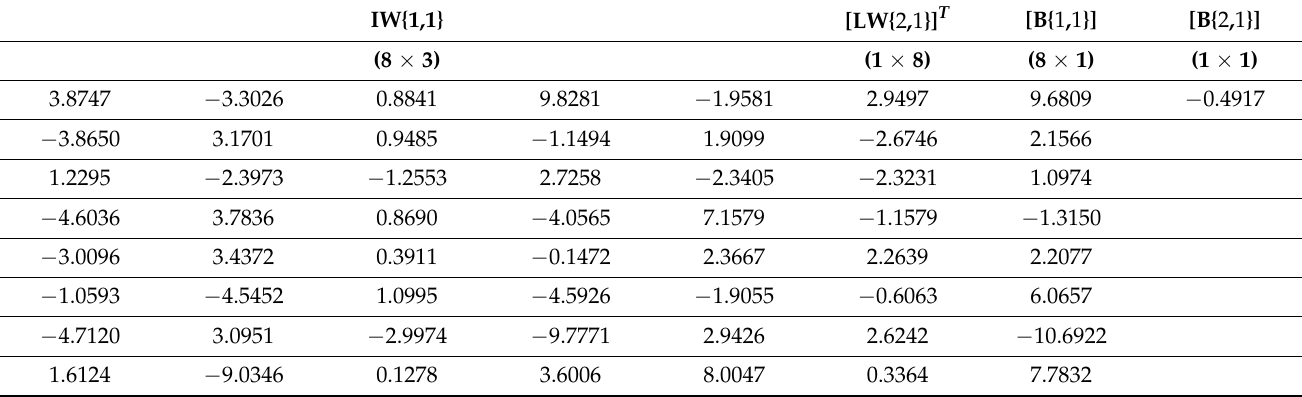
Table 8. Finalized weights and bias of the optimum ANN-LM 5-8-1